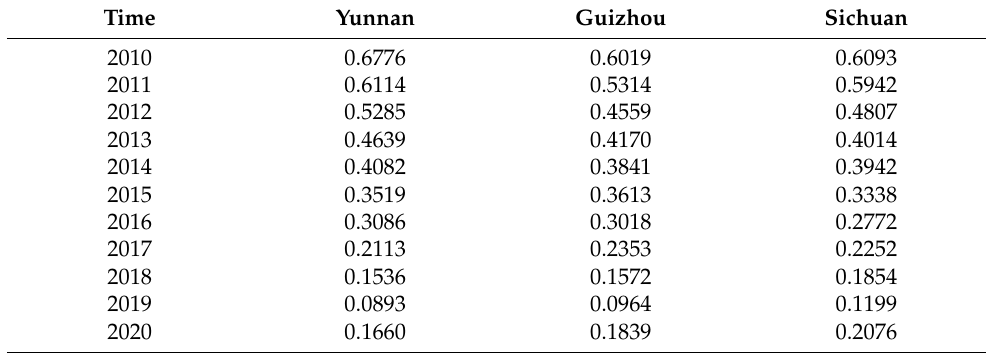
Table 3. Measurement results of the uncoordinated coupling in the Yunnan–Guizhou–Sichuan region. Time Yunnan Guizhou Sichuan 2010 0.6776